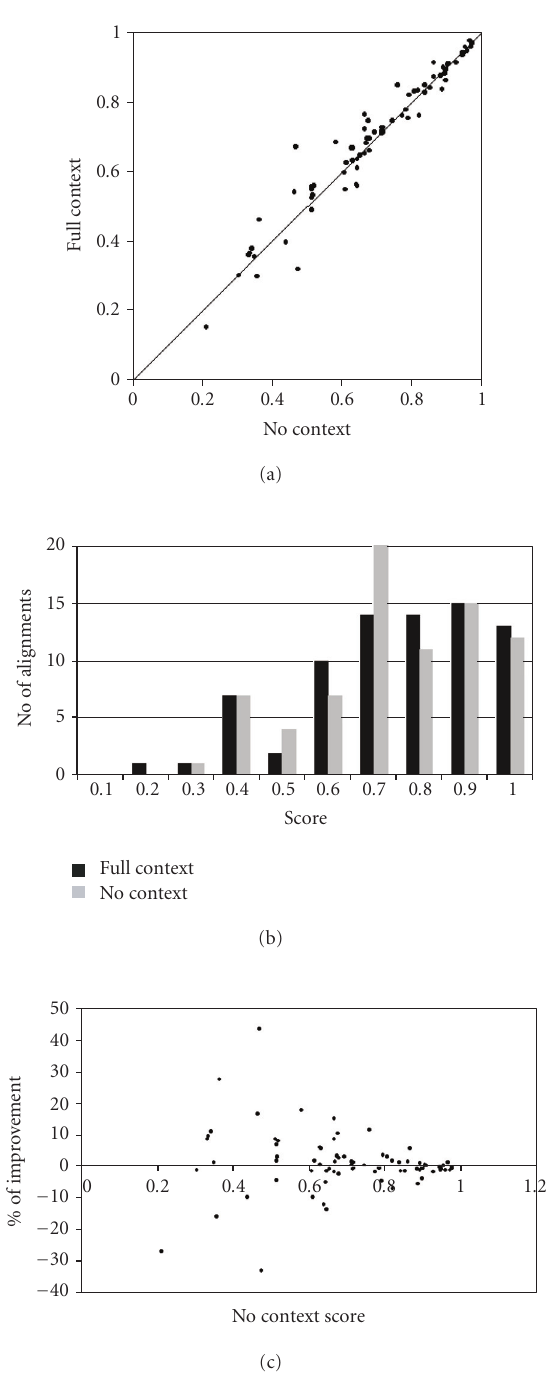
Figure 1. Comparison of Contextual and noncontextual scores. (a) SPS score comparison, (b) SPS score distributions, and (c) Improvement versus noncontextual score.